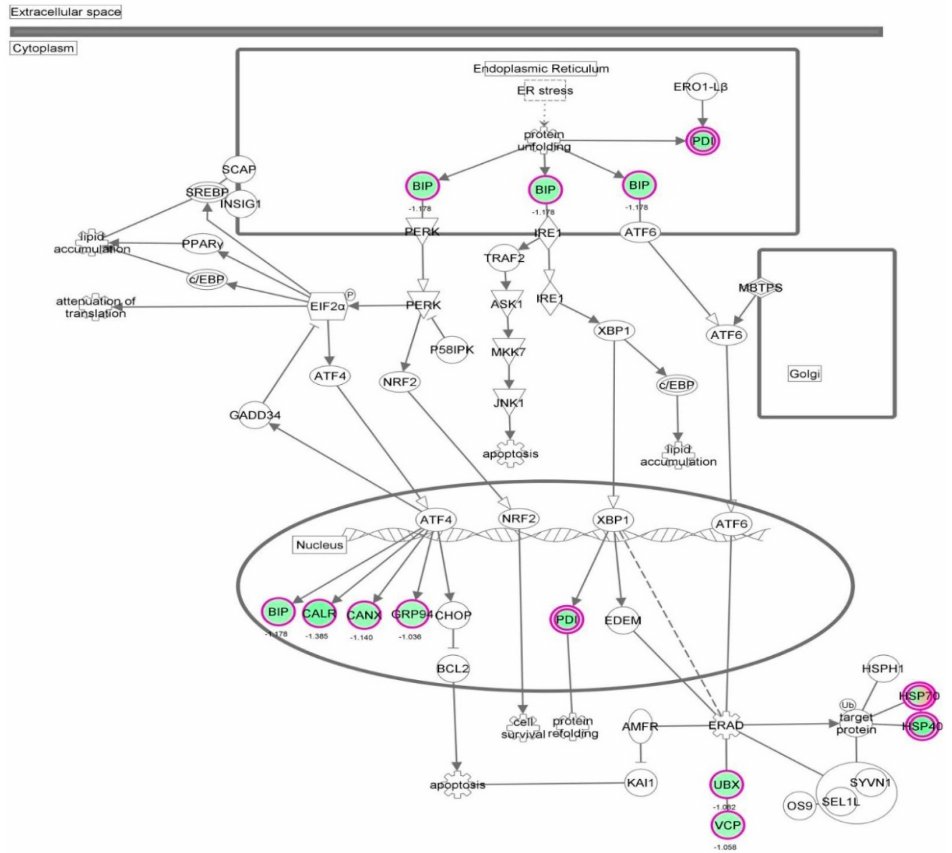
Figure 35. UPR signaling pathway was regulated by vancomycin in HK-2 cells. HK-2 cells were treated with 50 µ g/mL vancomycin for 24 h and the protein samples were subject to quantitative proteomic analysis. Green indicates a down-regulation. The intensity of green color indicates the degree of down-regulation. Solid arrow indicates direct